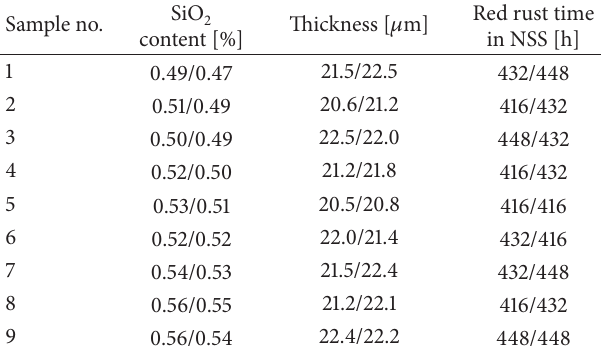
Table 5: SiO content (mass %), thickness, and erosion resistance of 2 composite coatings in different areas of iron plate for V = 1500 r/min and ℎ = 20 mm. Sample